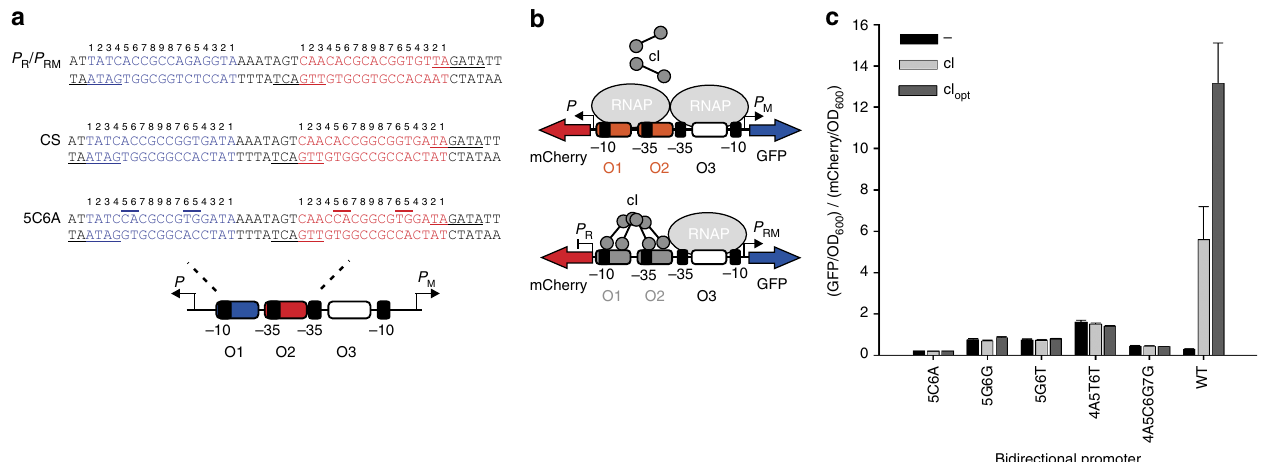
Figure 3 | Design and characterization of engineered promoters with no activation by wild-type (WT) cI. ( a ) Synthetic promoters were designed by making symmetric variants of the consensus sequence (CS) based on the six natural l operators. Each operator contains a consensus (1–8) and a non-consensus half-site (8–1), which were modified for each synthetic promoter. The engineered promoters were named after the position of the base substitution in the consensus half-site. As an example, the promoter 5C6A contains two base pair mutations at positions 5 and 6 (overlined). The (cid:2) 35 and (cid:2) 10 regions are underlined for each bidirectional promoter. ( b ) Scheme of the l cI binding assay with GFP and mCherry as reporter proteins. Binding of WTcI to the WT promoter (P R /P RM ) results in activation of GFP and simultaneous repression of mCherry. ( c ) Experimental results of the binding assay. GFP and mCherry were normalized to OD 600 and the ratio was calculated. The lack of binding of l cI and cI opt against synthetic promoters was confirmed by the reporter assay. Error bars are 1